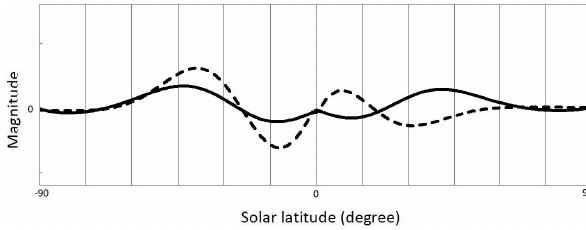
Fig. 4. Simulations for the two quadruple components of the poloidal magnetic field reproducing the latitudinal SBMF distri- bution for cycle 21: dashed line with the parameters: D 1 = − 700, V =0.8 (region of positive latitude), and V =0.3 (region of negative latitude); solid line with the parameters: D 2 = − 500, v = − 0.1 (re- gion of positive latitude), and v = − 0.3 (region of negative latitude).